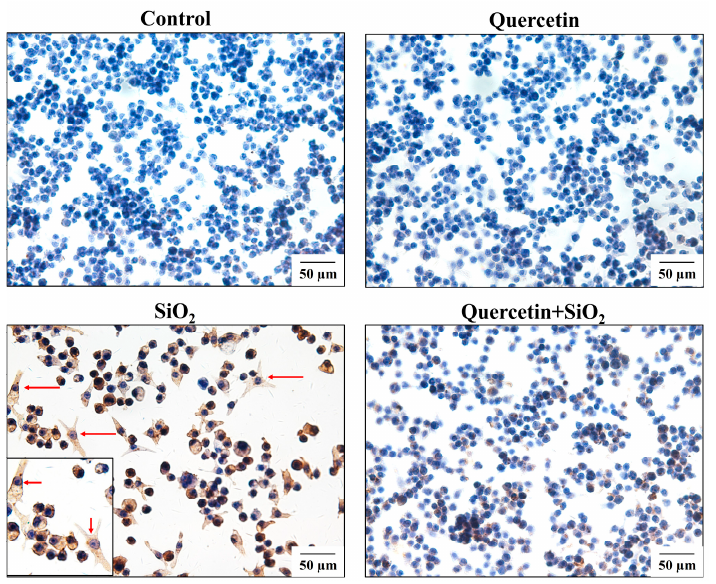
Figure 8. The expression of α -SMA in MH-S, measured by immunocytochemical staining (scale bar = 50 µm).